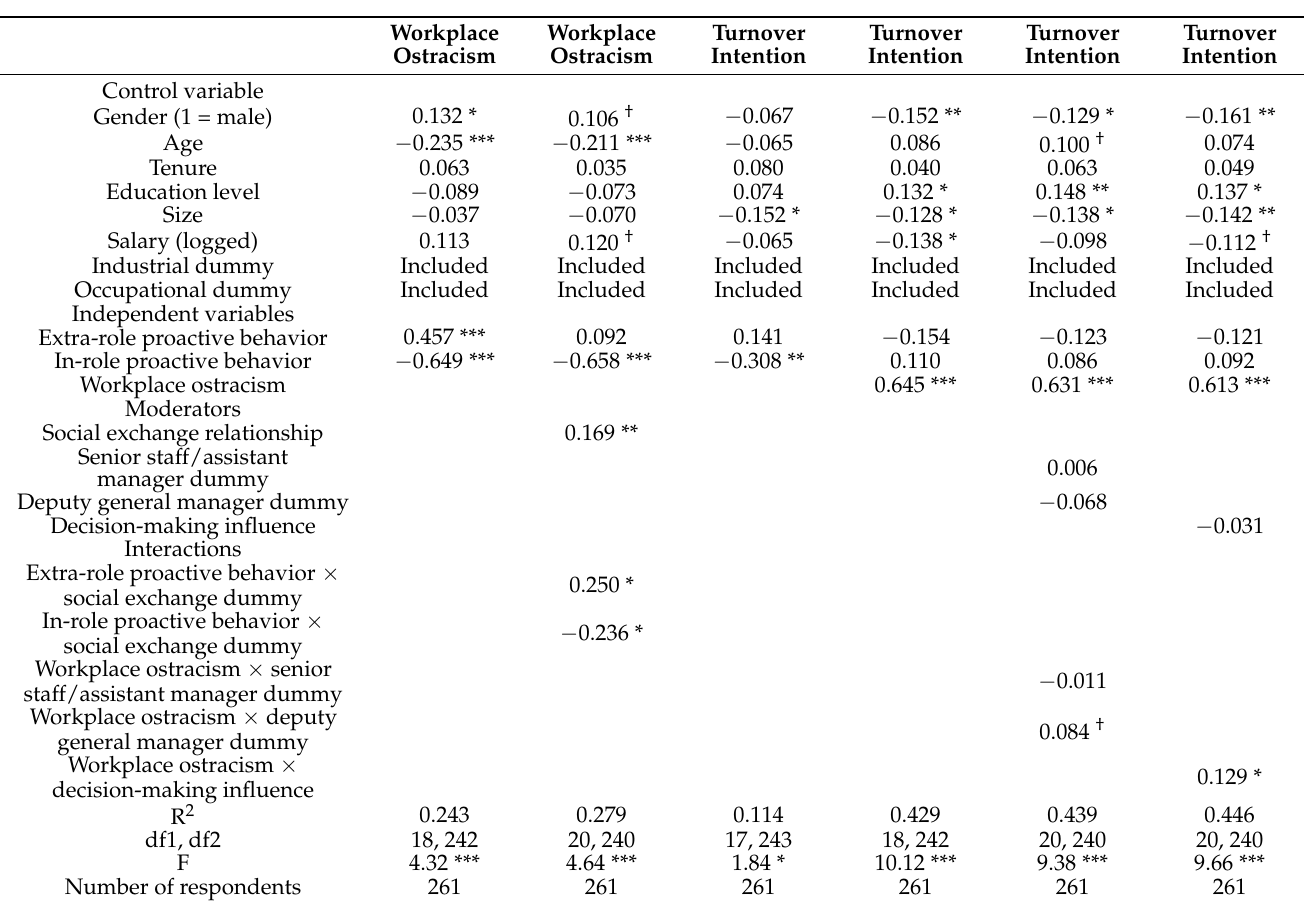
Table 3. Results of multiple regression